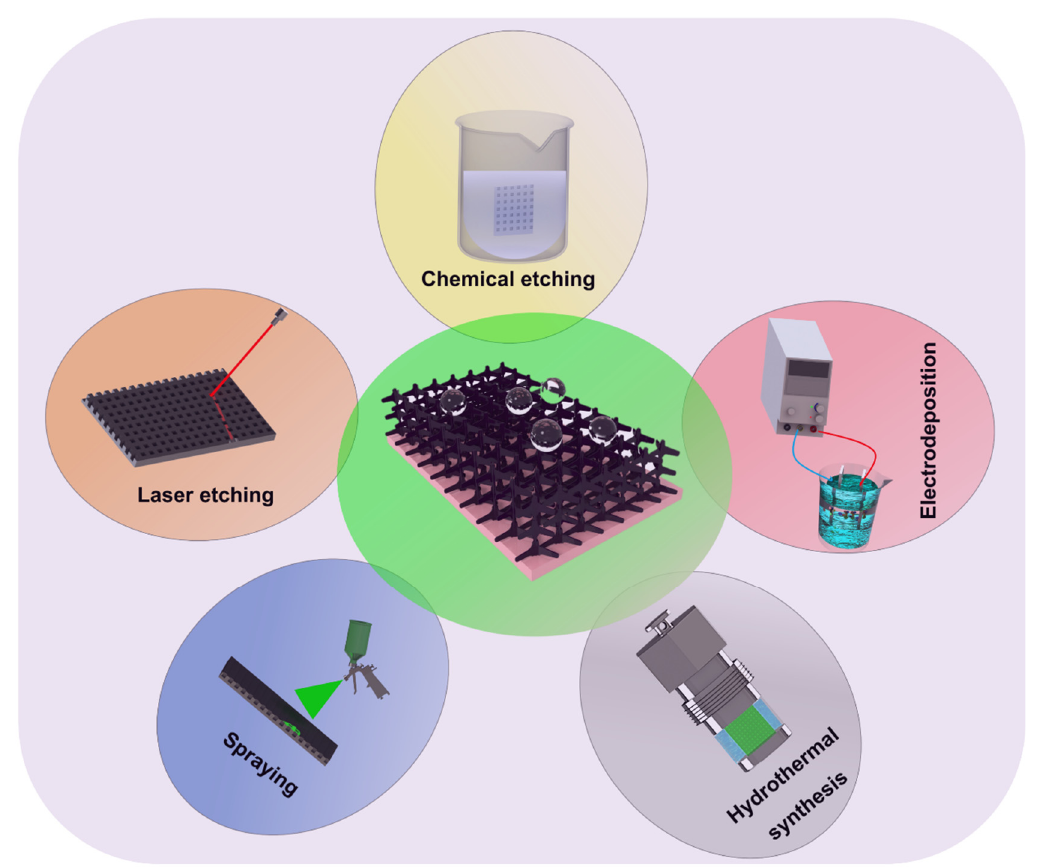
Figure 5. Fabrication strategies of superhydrophobic coatings.